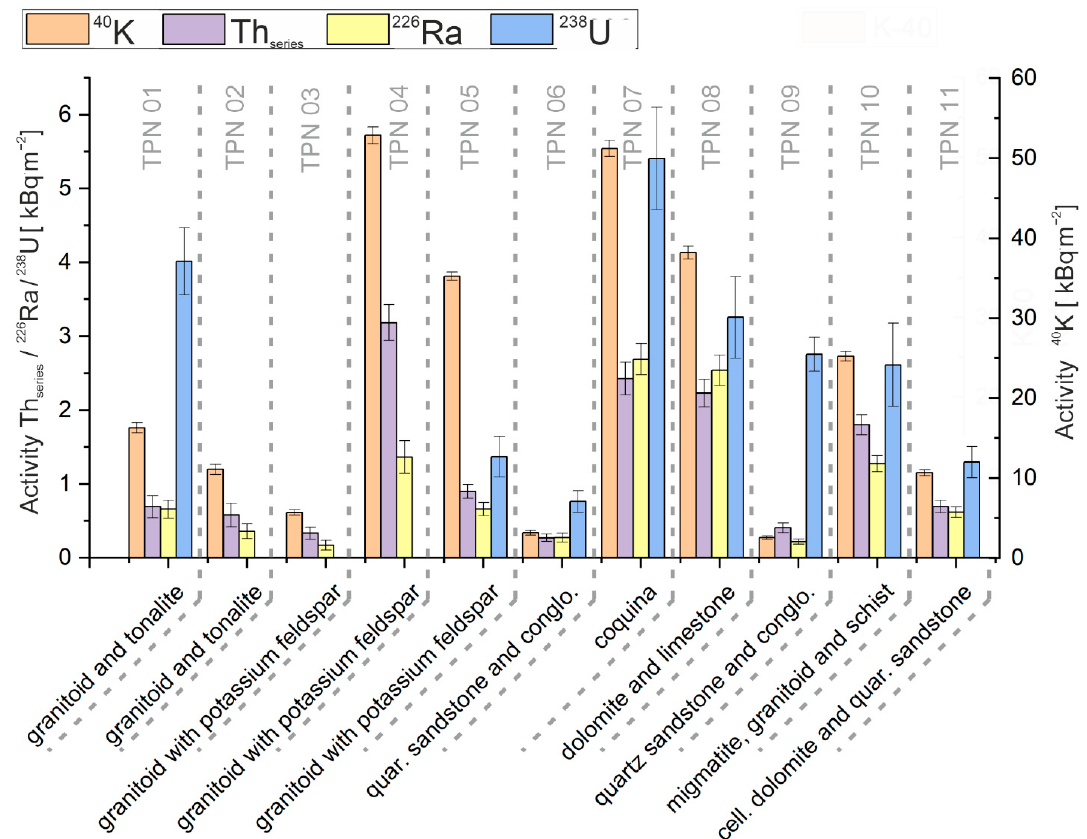
Figure 6. The surface emission rate of individual soil samples with correlation to the bedrock.